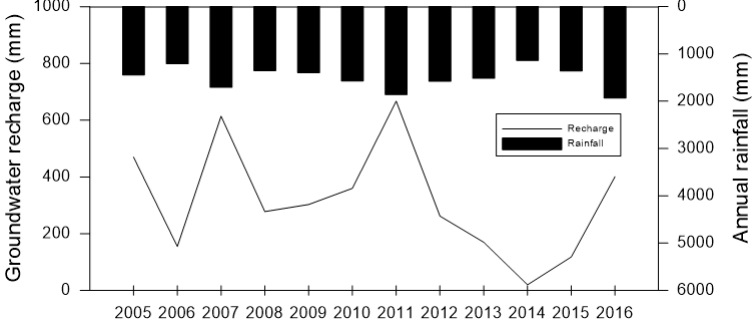
Figure 6. Annual groundwater recharge estimates by the water-table fluctuation (WTF) method.